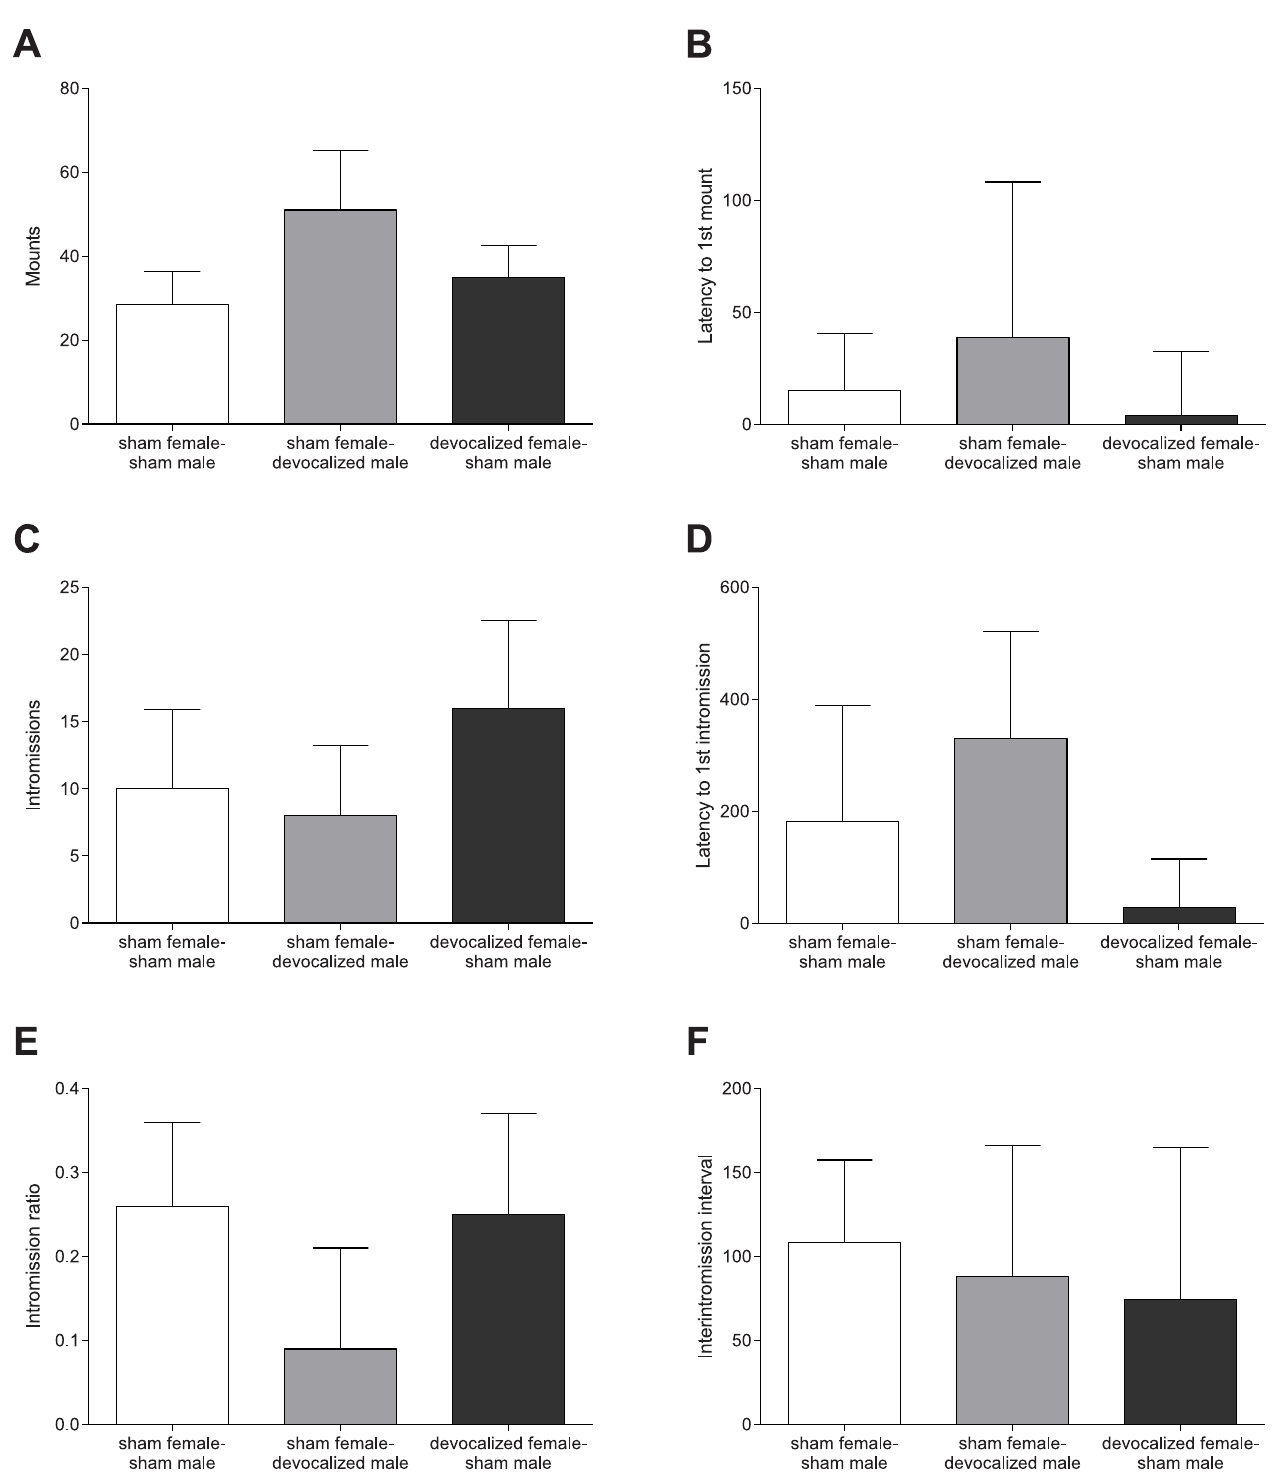
Fig 2. No differences in male copulatory behavior. (A) The number of mounts, (B) the latency to the first mount, (C) the number of intromissions, (D) the latency to the first intromission, (E) the intromission ratio, and (F) the interintromission interval performed by the males. All graphs show the comparison between sham females paired with sham males, sham females paired with devocalized males and devocalized females paired with sham males. Data are shown as median ± semi interquartile range.